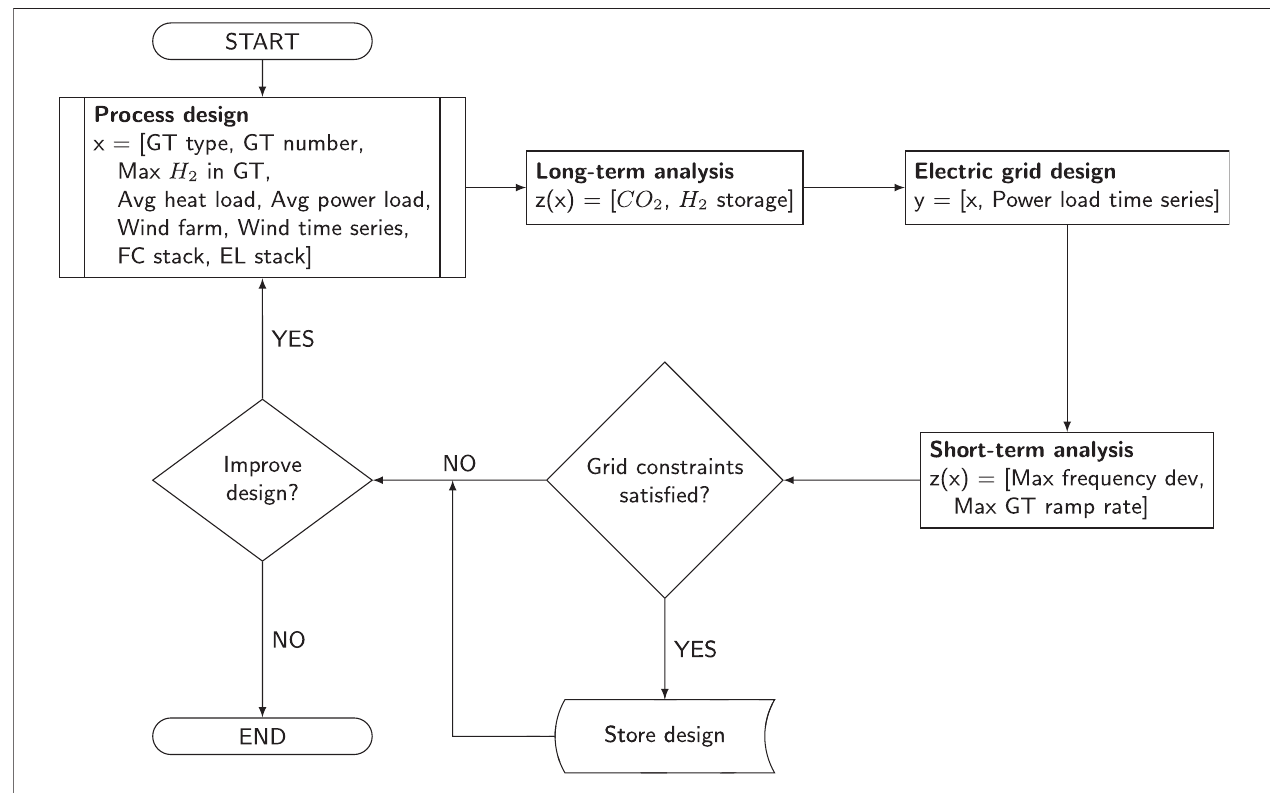
FIGURE 2 | Flowchart of the proposed design methodology combining models of the process and electric domains.